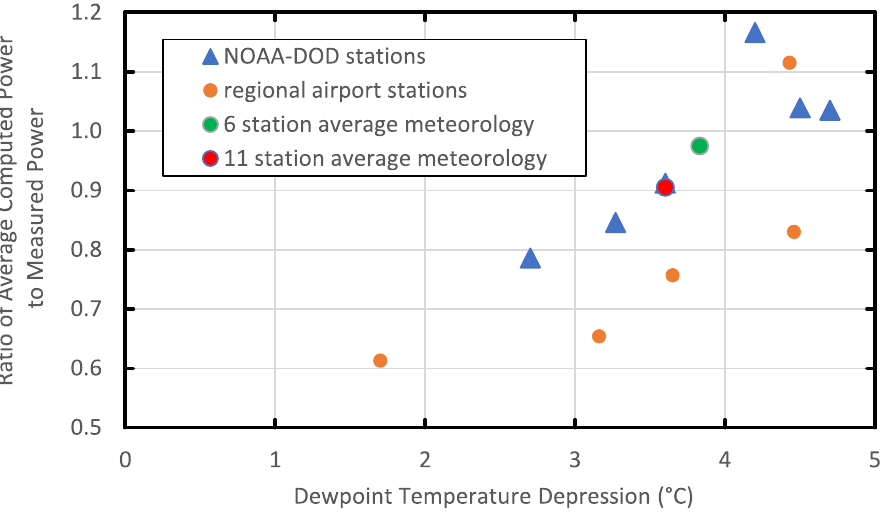
Figure 9. Comparison to measured average power ratios correlated with DPTD.